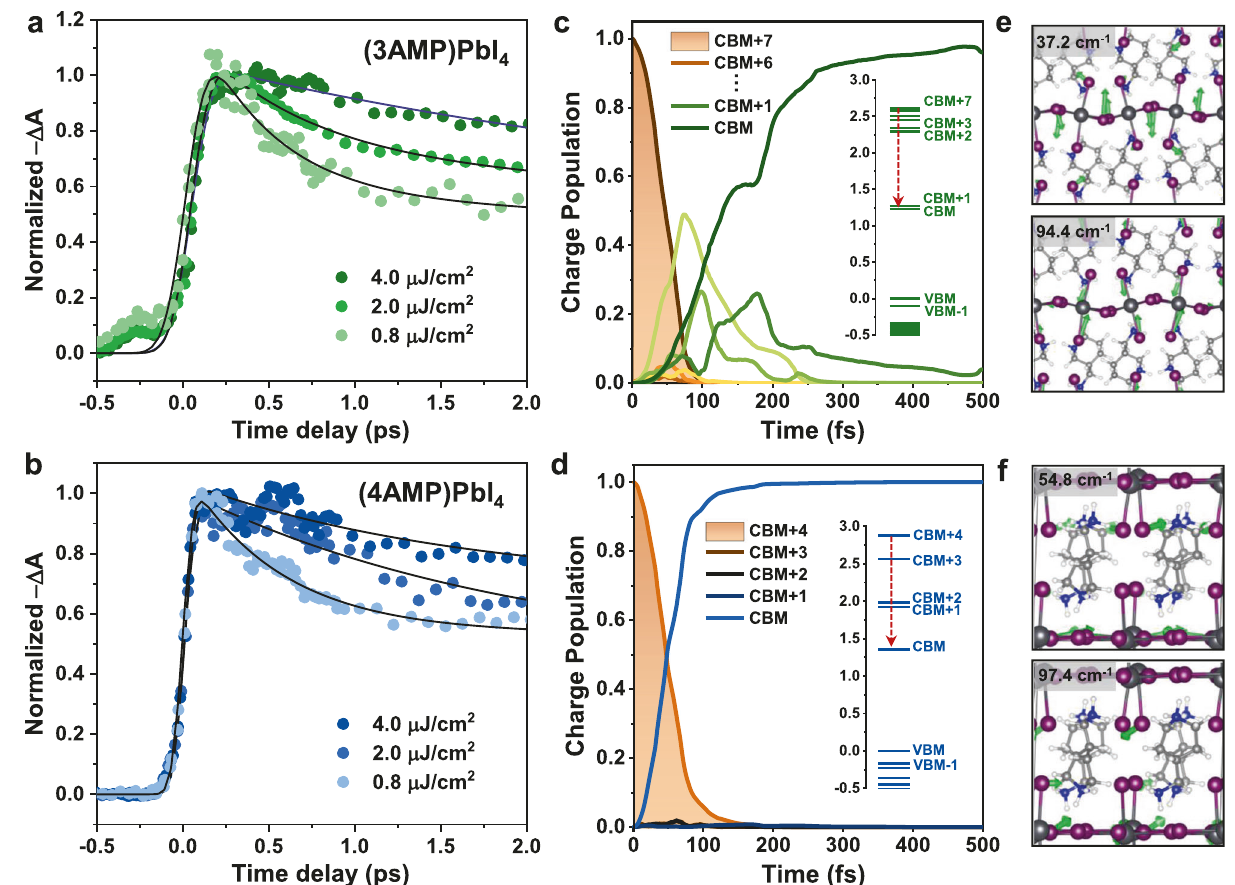
Fig. 3 Kinetics and intraband relaxation in 2D Dion – Jacobson perovskites. Normalized transient absorption kinetics ( a ) probed at a wavelength of 554 nm for the (3AMP)PbI 4 fi lm (excitation at 330 nm) and ( b ) probed at a wavelength of 518 nm for the (4AMP)PbI 4 fi lm (excitation at 316 nm), with different pump fl uences of 0.8 μ J/cm 2 , 2.0 μ J/cm 2 , and 4.0 μ J/cm 2 . The solid lines show best fi ts to the experimental data with an exponential function. Time evolution of hot electron relaxation ( c ) starting from CBM + 7 for (3AMP)PbI 4 (excess energy = 1.52 eV) and ( d ) starting from CBM + 4 for (4AMP) PbI 4 (excess energy = 1.38 eV). Inserts show the electronic energy levels of (3AMP)PbI 4 and (4AMP)PbI 4 at the high-symmetry Γ -point and B-point, respectively, involved in the nonadiabatic molecular dynamics calculations (NAMD). Vibrational modes responsible for the intraband relaxation in ( e ) (3AMP)PbI 4 and ( f ) (4AMP)PbI 4 (the vibrational motions of the organic cations are omitted). The DFT and NAMD calculations were performed at the GGA/PBE level with both perovskite fi lms show an instantaneous rise in the photo- bleaching signals that occur at subpicosecond timescales, i.e., – 200 fs for (3AMP)PbI ≤ 120 fs for (4AMP)PbI 4 and 120 4 at pump